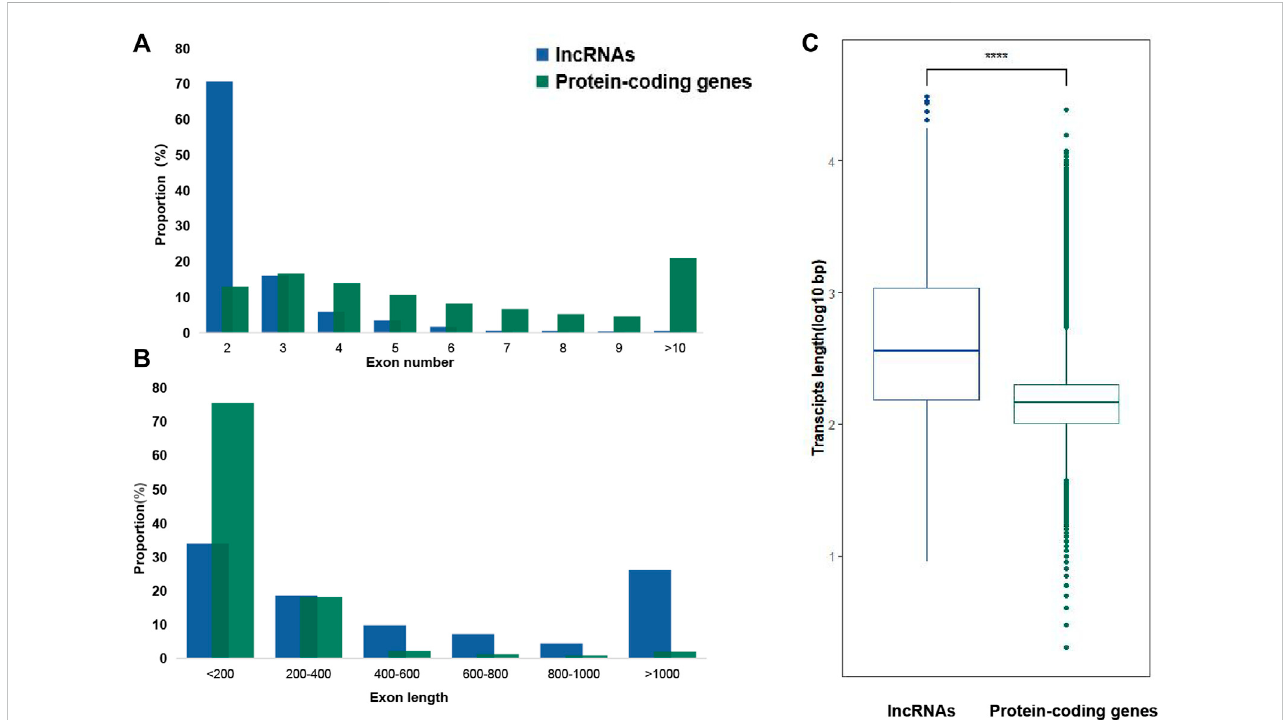
FIGURE 2 LncRNA gene structural features of SSB. (A) Exon numbers of lncRNAs and protein-coding genes. (B) Distribution of exon sizes of lncRNA and protein- coding genes. (C) Transcript length comparison of lncRNAs and protein-coding genes. On average, lncRNAs have longer transcripts than protein-coding genes.